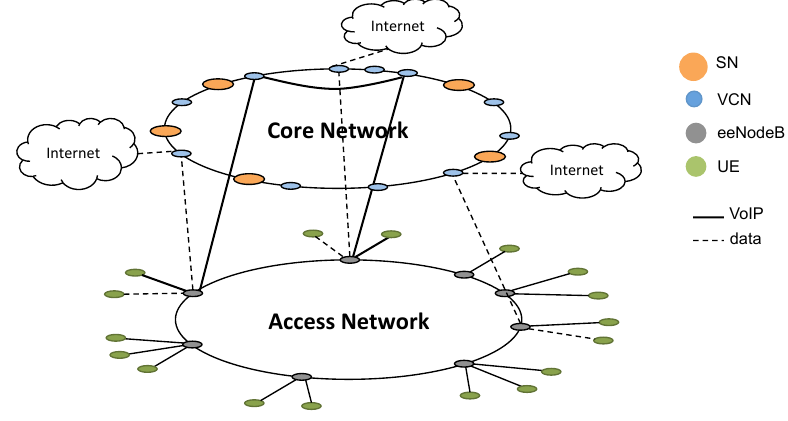
Figure 3. New virtualized cellular